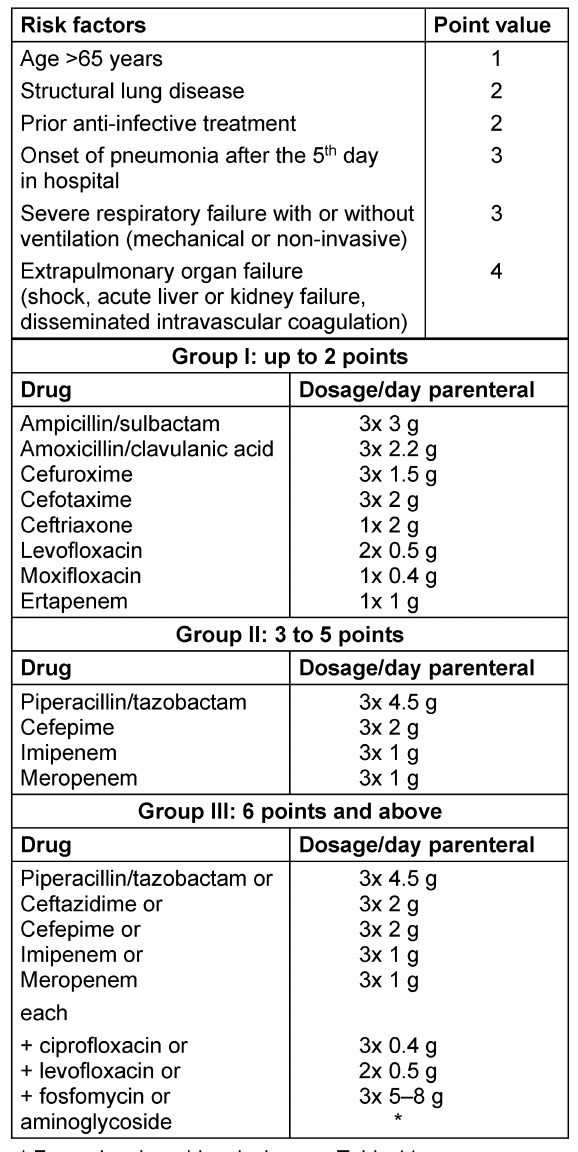
Table 12: Score assessment of risk factors in patients with nosocomial pneumonia and recommendations for